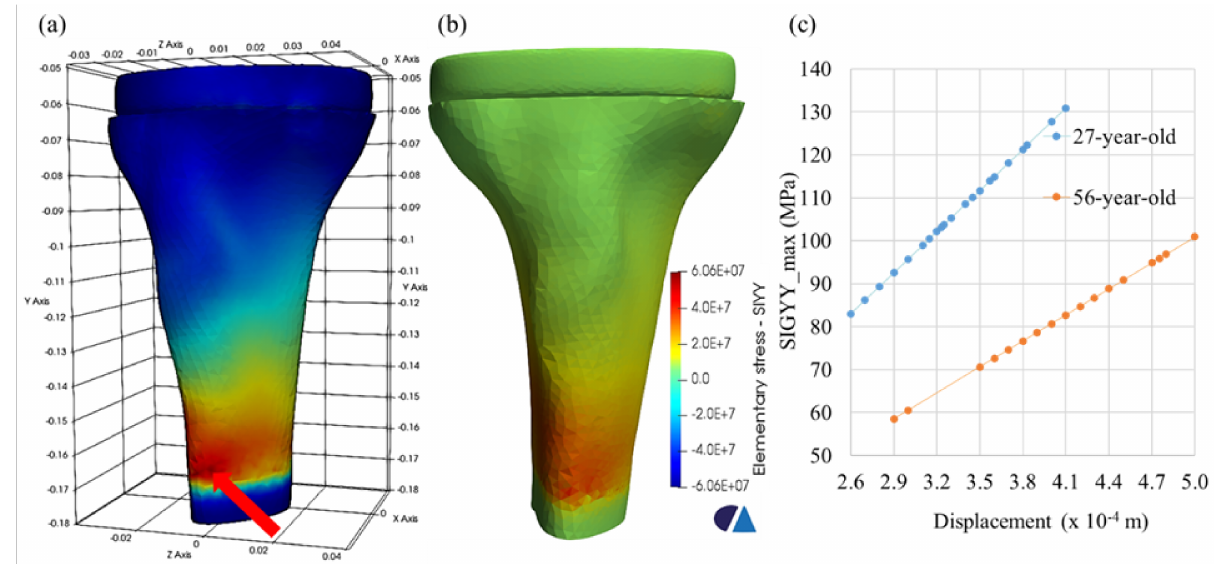
Figure 10. Maximum stress location (red arrow) of the 56-aged model, ( a ) the distribution of the stress component SIGYY of the 56-aged model ( b ), and the history of SIGYY_max versus the displacement at the maximum stress location ( c ).